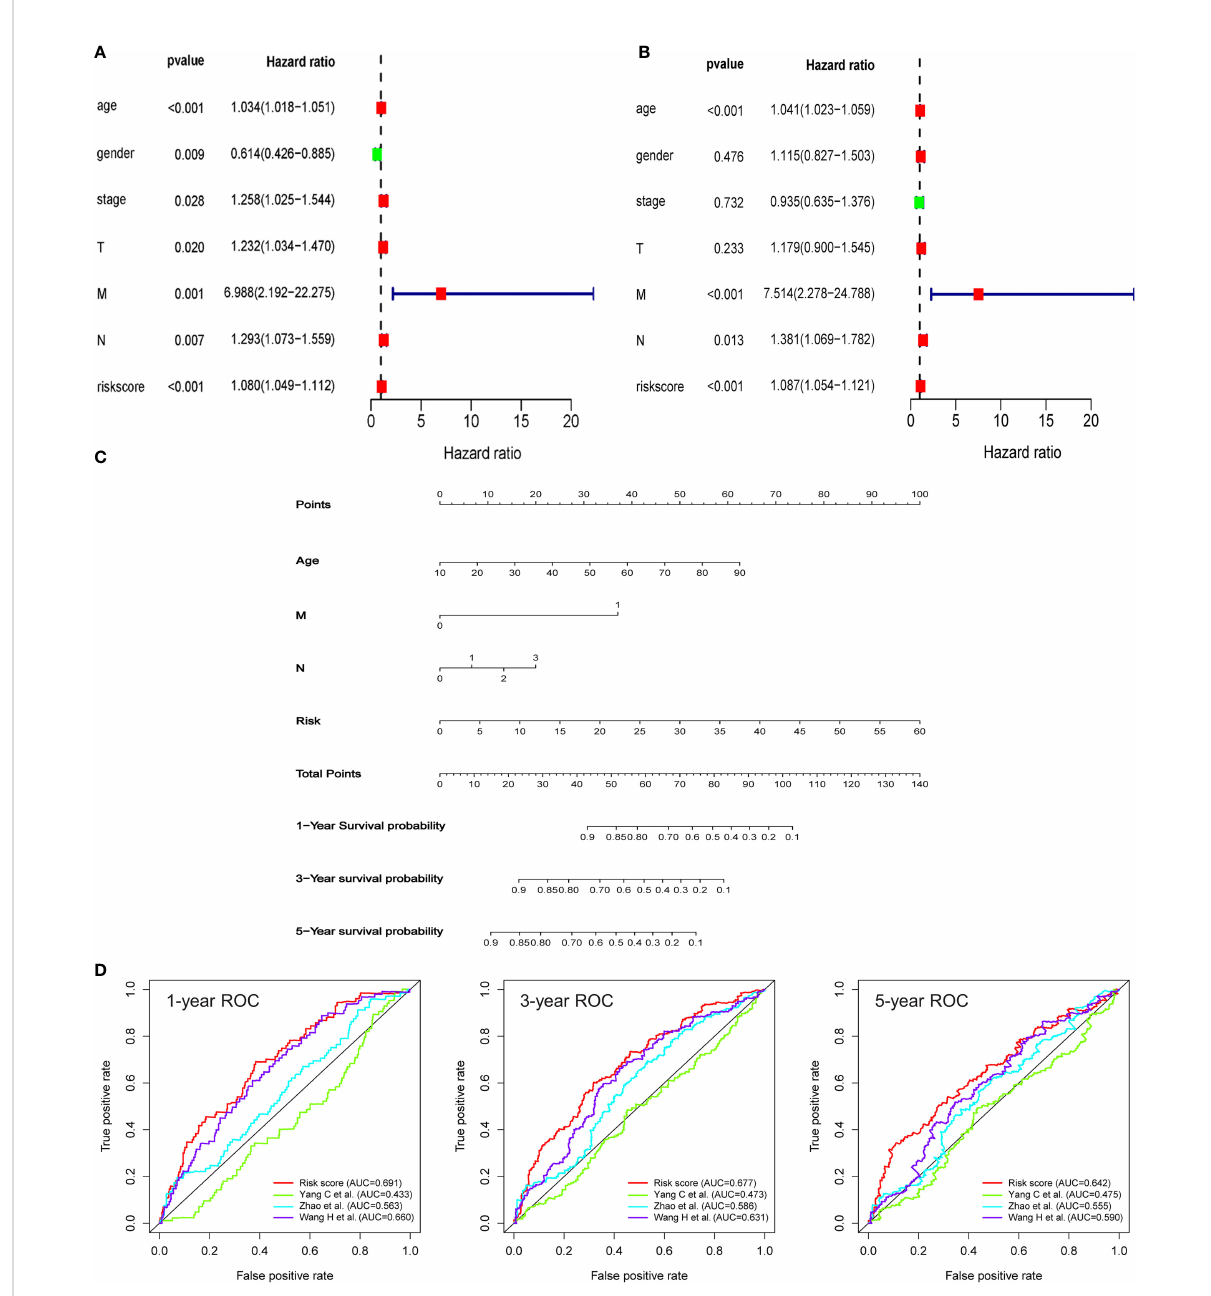
FIGURE 4 An HRG-based signature as an independent prognostic model. (A, B) The univariate and multivariate Cox regression models indicated that the risk score was an independent prognostic predictor for overall survival. (C) A nomogram to predict survival probability at 1-, 3 ‐ , and 5 ‐ year after surgery for HNSCC patients based on the results deriving from the entire set. (D) ROC curves for different prognostic signatures. The AUC values for the present signature of 1-year, 3-year, and 5-year were 0.691, 0.677, and 0.642, respectively, and these values were signi fi cantly higher than another three existing